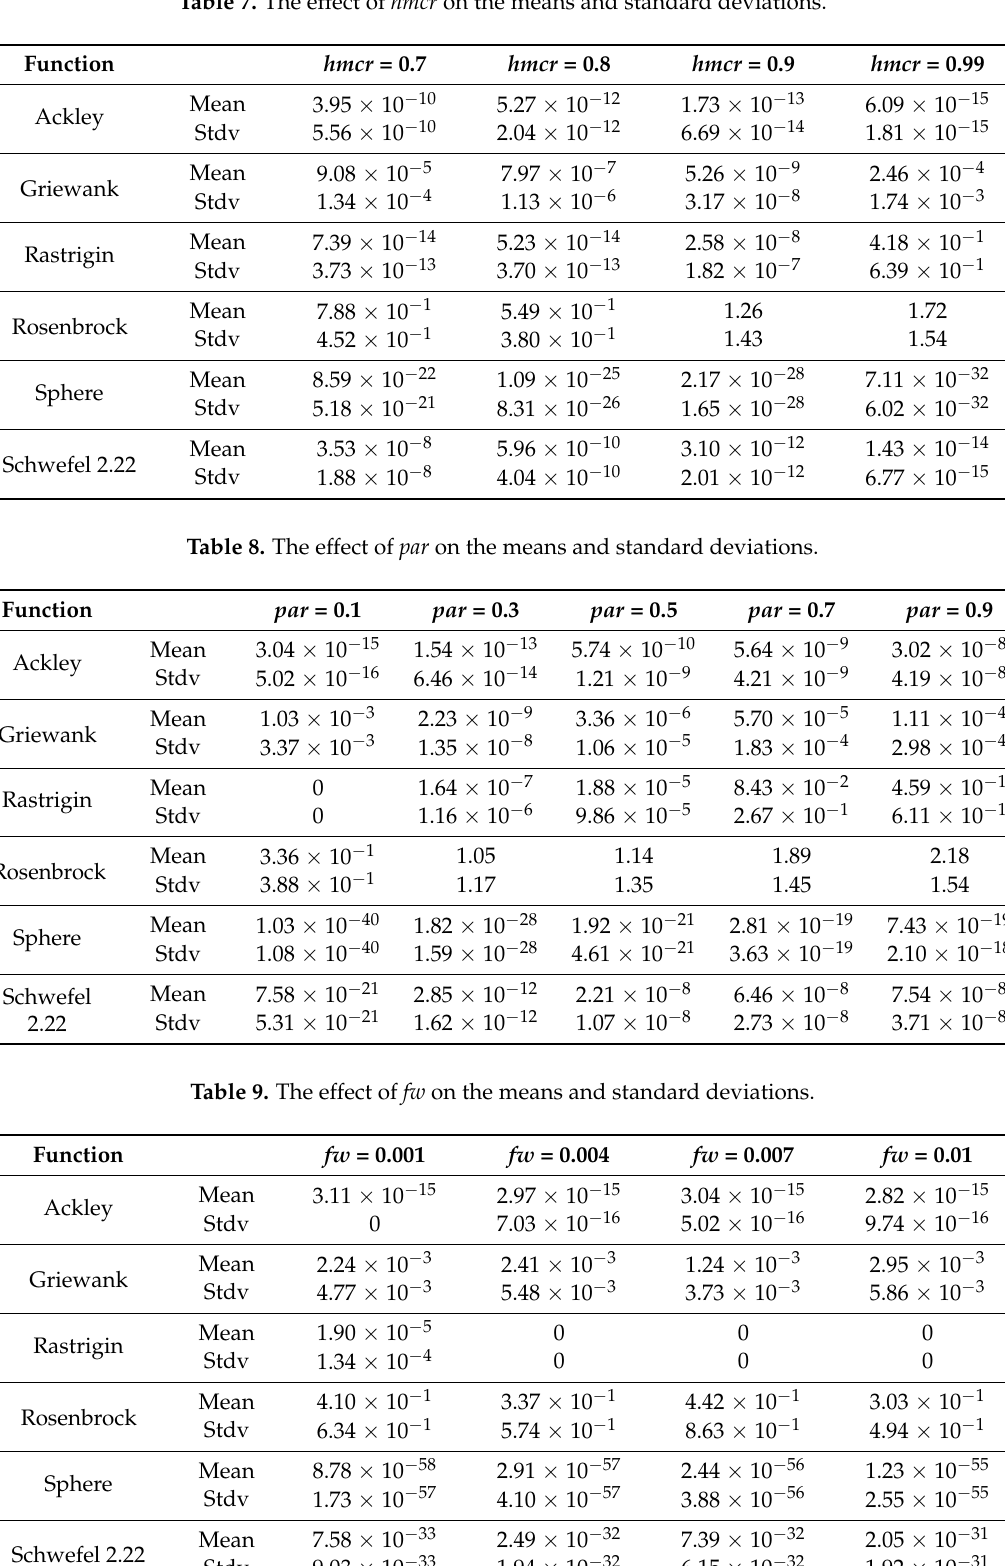
Table 7. The effect of hmcr on the means and standard deviations.